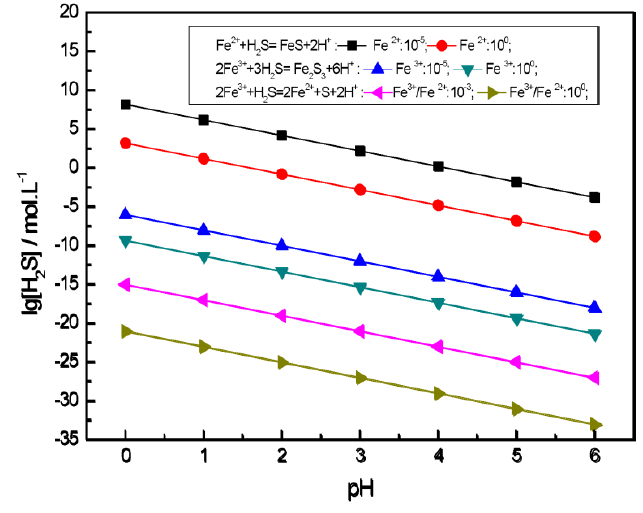
Figure 6. H 2 S concentration balanced with Fe 2+ and Fe 3+ under different concentrations.